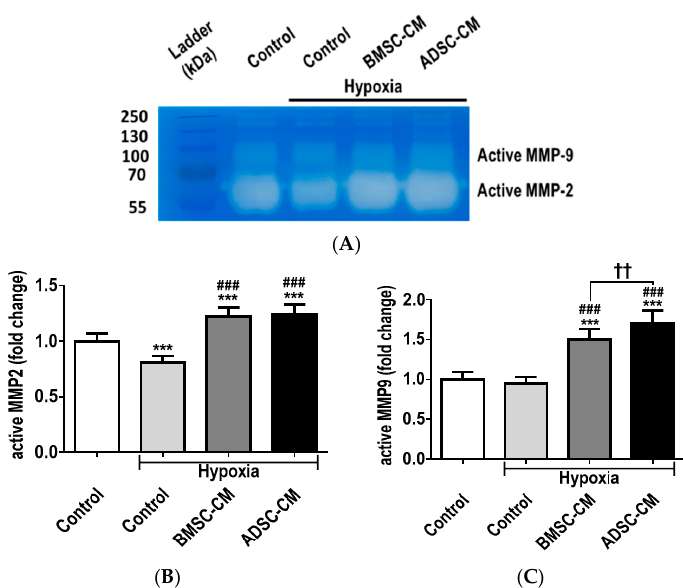
Figure 4. ( A ) Gelatin zymography for the detection of MMPs, ( B ) active MMP-2 and ( C ) MMP-9 protein secretion by primary rat AECs treated with human MSC-CM during hypoxic (1.5% O 2 ) exposure for 24 h to assess injury index. The activities of active MMP-2 and MM-9 were quantified using densitometry. Data presented as mean ± SD; n = 3 (*** p < 0.001 vs. normoxia control; ### p < 0.001 vs. hypoxia control and †† p < 0.01 vs. BMSC-CM). The resulting data were statistically analysed using one-way ANOVA and Tukey’s multiple comparison test.